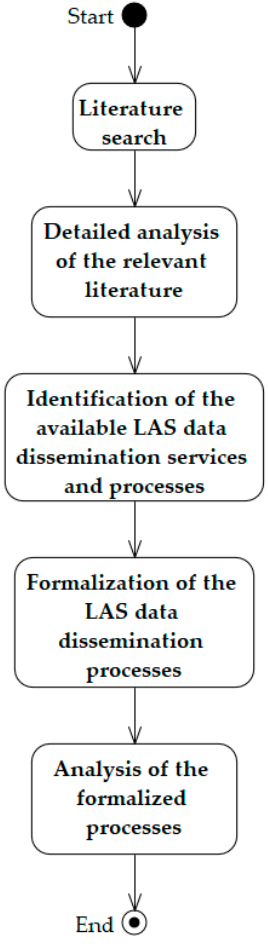
Figure 1. Research workflow. Source: Own